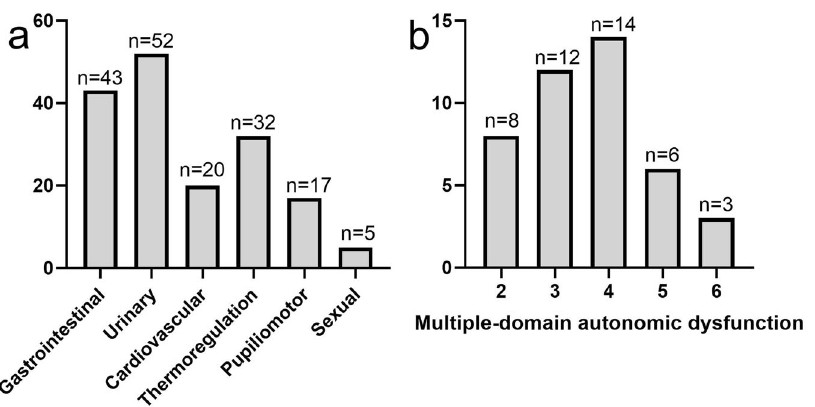
Fig. 1 Different autonomic symptoms in PD patients. The frequency of different autonomic symptoms in PD patients ( a ), and the frequency of domains involved in the AutD-M group ( b Fig. 1a. Urinary complaints were primarily incontinence, incom- plete emptying and increased frequency, whilst gastrointestinal complaints included constipation, swallowing dif fi culties and sialorrhea. Other autonomic symptoms include hyperhidrosis (thermoregulatory), light-headiness when standing up (cardiovas- cular), and oversensitivity to bright light (pupillomotor). Erectile dysfunction and retrograde ejaculation in men and reduced vaginal lubrication and orgasm were reported in females.